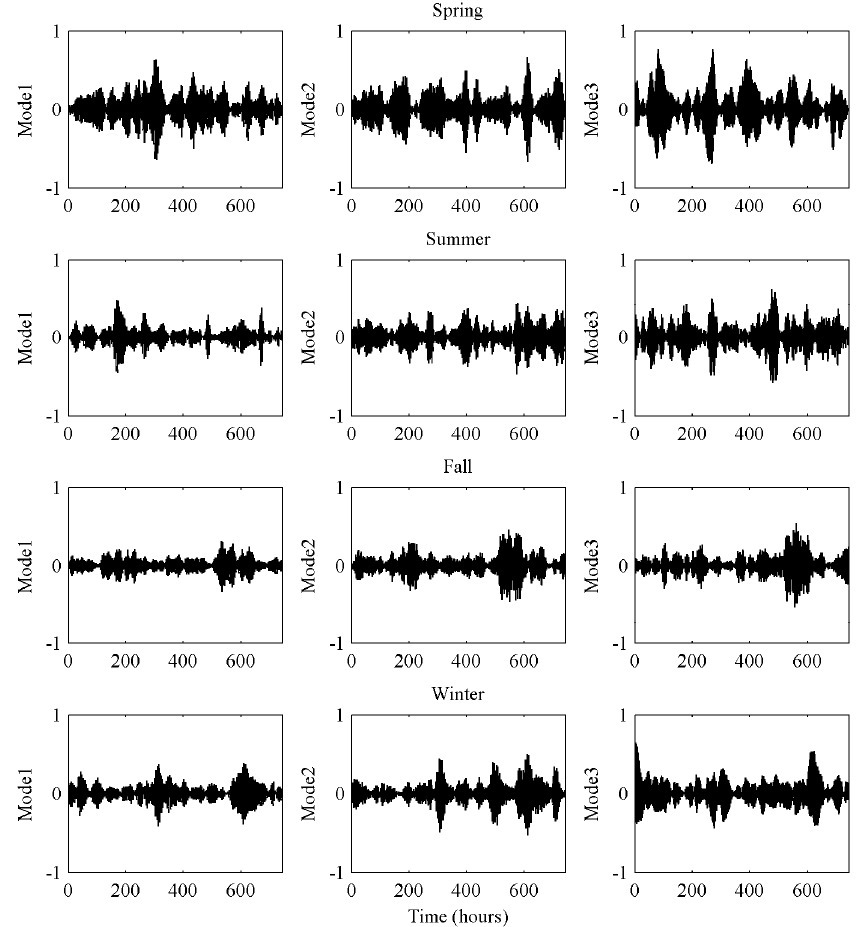
Figure 6. The decomposed results of IMF1 using VMD in four cases.